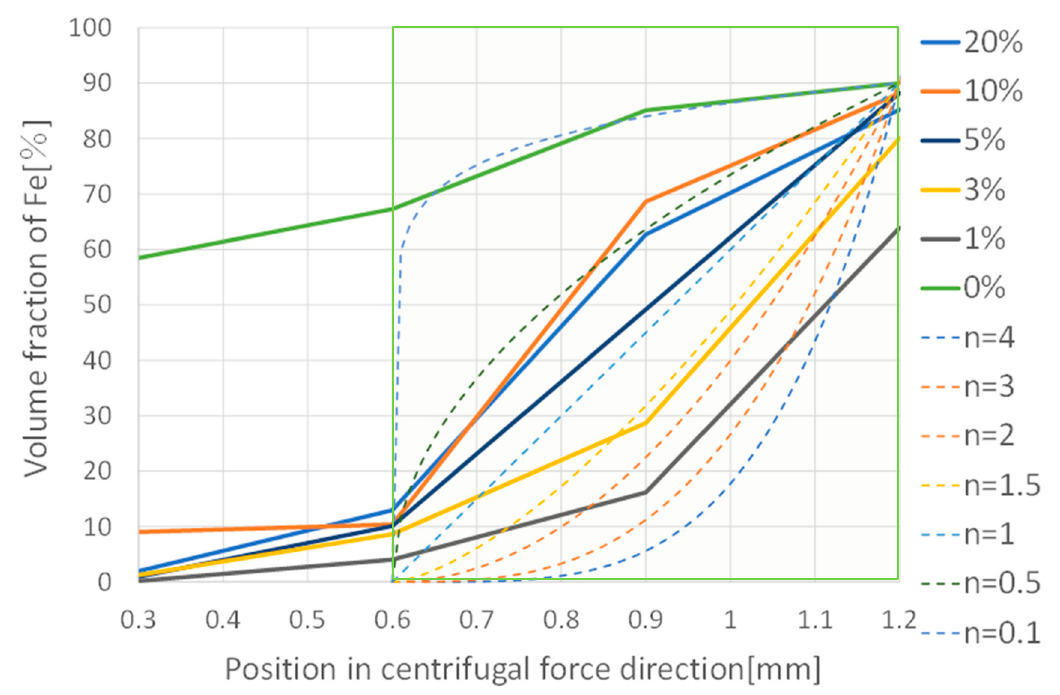
Figure 10. Compositional gradient distributions for the FGMs with the rotating speed of 250 rpm with fitting curves expressed by Equation (2). The experimental data for PCA from 0 to 20% and fitting curves from n = 0.1 to 4 are shown. The part surrounded by a green line corresponds to the functionally graded layer.